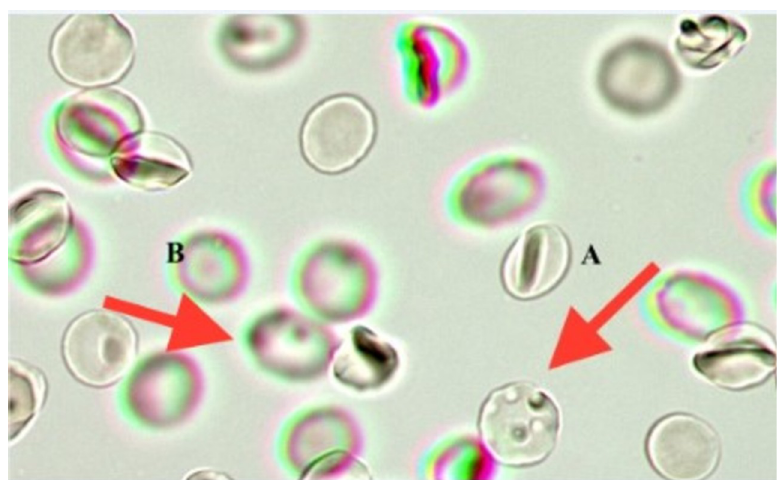
Fig 1. Image of pitted erythrocytes (indicated by arrow A) and Howell-Jolly bodies (indicated by arrow B).